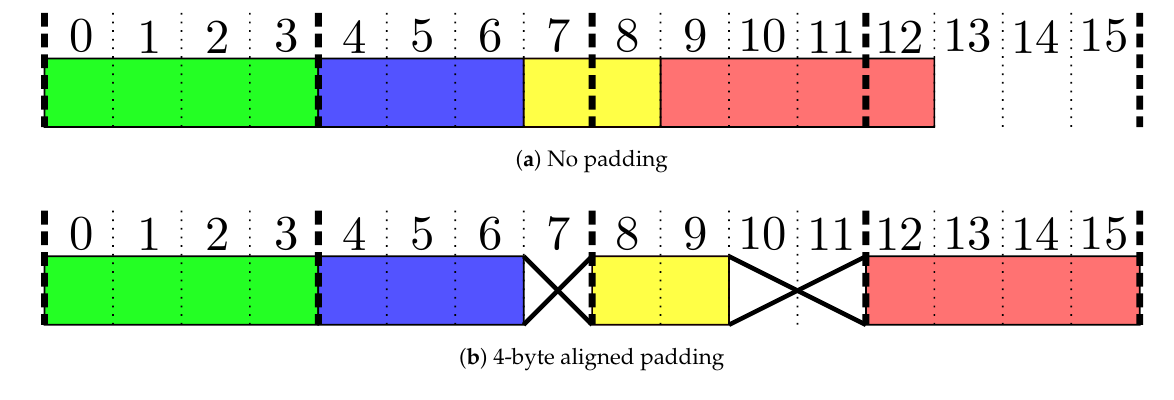
Figure 6. Four queued packages with and without padding. The crosses represent dont-care data, which may be zeroed